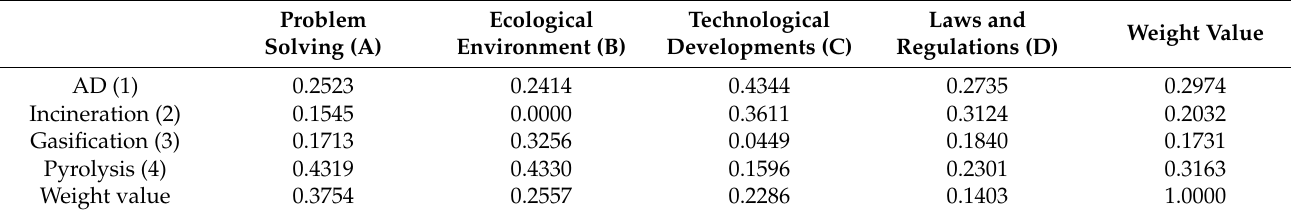
Table 4. Weight values according to the standard energy utilization